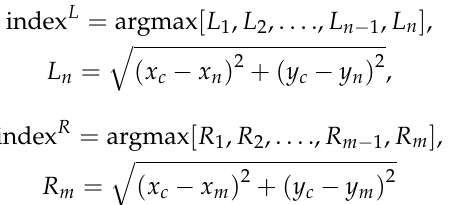
Figure 6. Object detection.